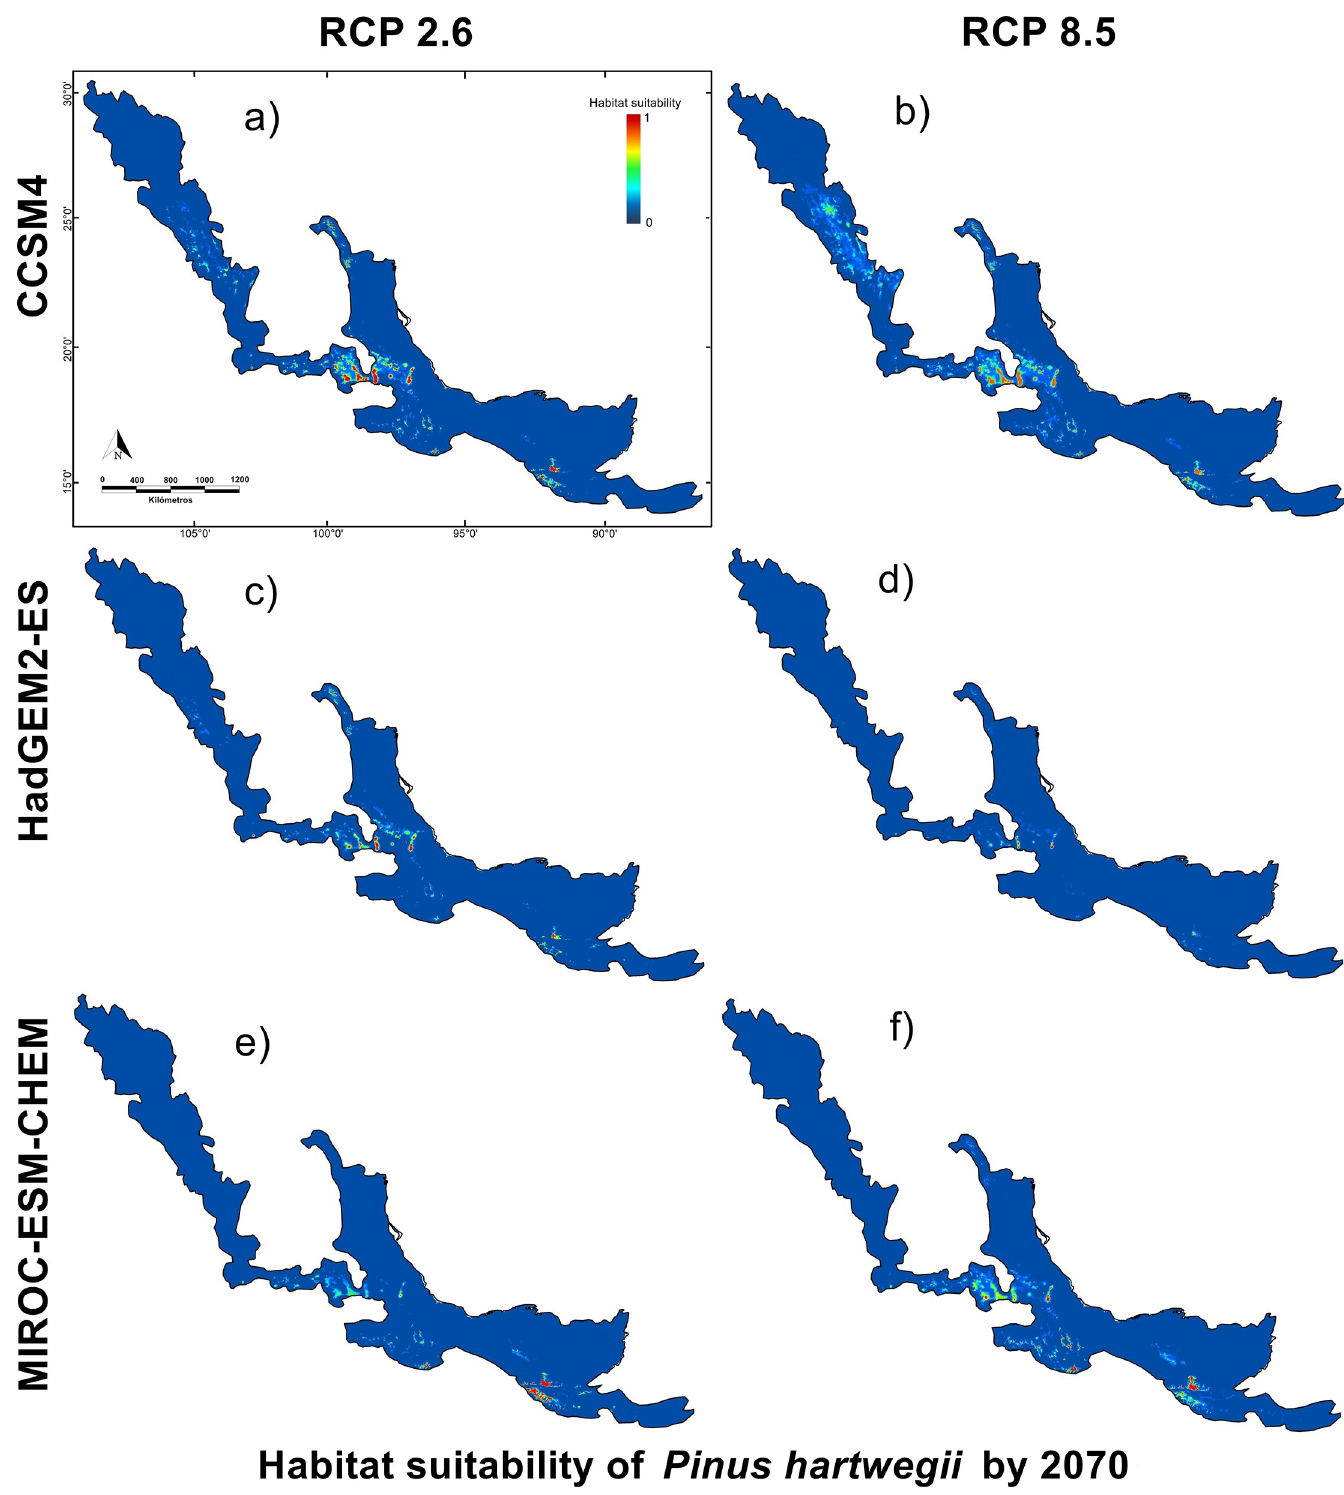
Fig 7. Climate niche model of P . hartwegii for 2070. Models comparing three general circulation models used MIROC-ES-CHEM, CCSM4, and HadGEM2-ES in combination with the two Relative Concentration Pathways used RCP’s 2.6 and 8.5 for the horizon 2070.